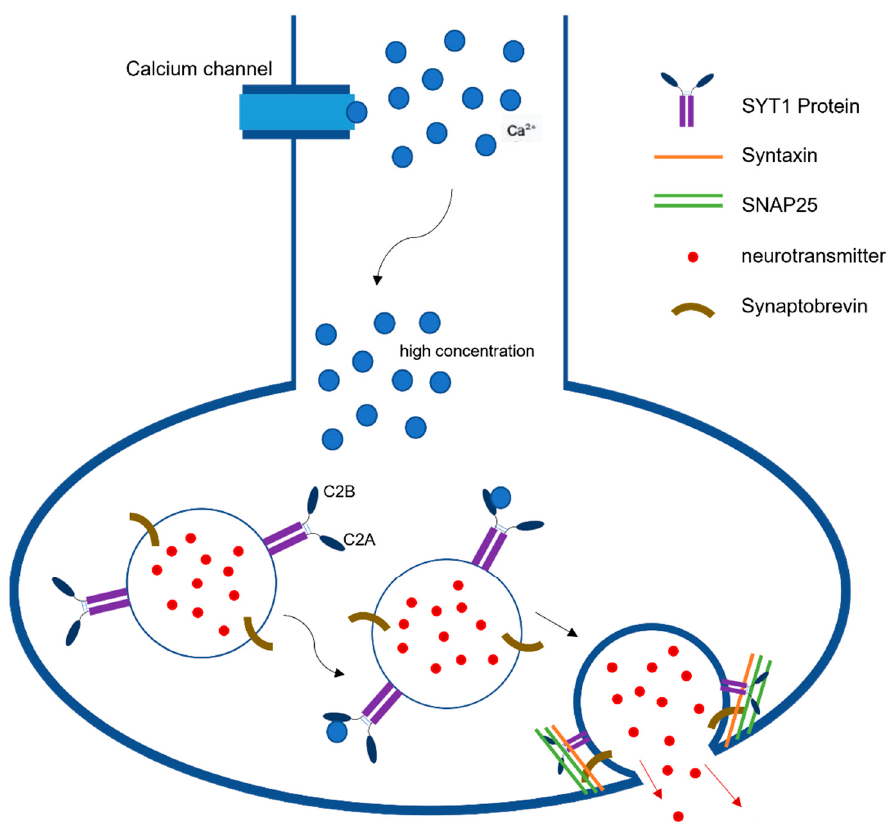
Figure 1. Synaptotagmin-1 Function in Neurotransmission. SYT1 plays a pivotal role in synaptic neurotransmission as a dual Ca 2+ sensor able to carry out both endocytosis and exocytosis independently. This figure describes the release of neurotransmitters following the detection of high concentrations of Ca 2+ by SYT1’s C2B domains.